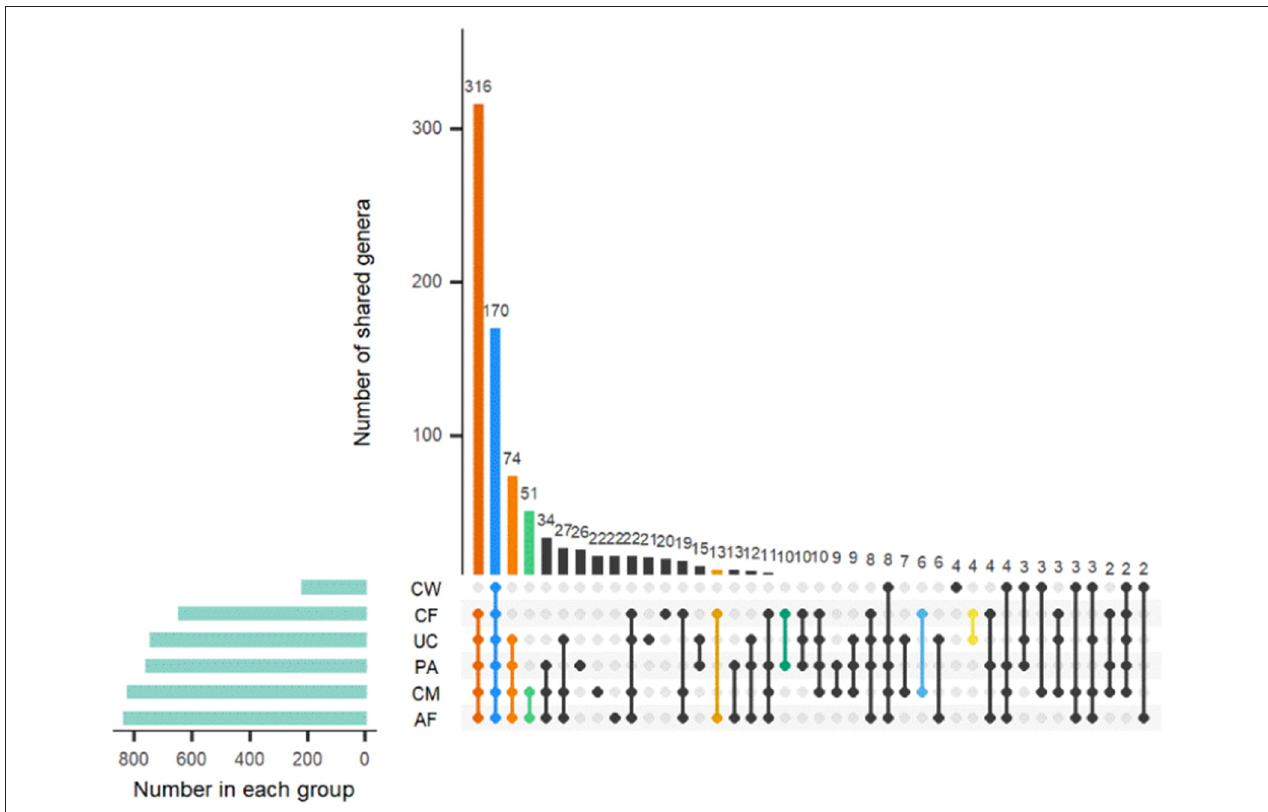
FIGURE 4 | Distribution of OTUs shared among different sample types. AF, amniotic fluid; CF, calf meconium; CM, colostrum; CW, cow feces; PA, placenta; UC, umbilical cord.